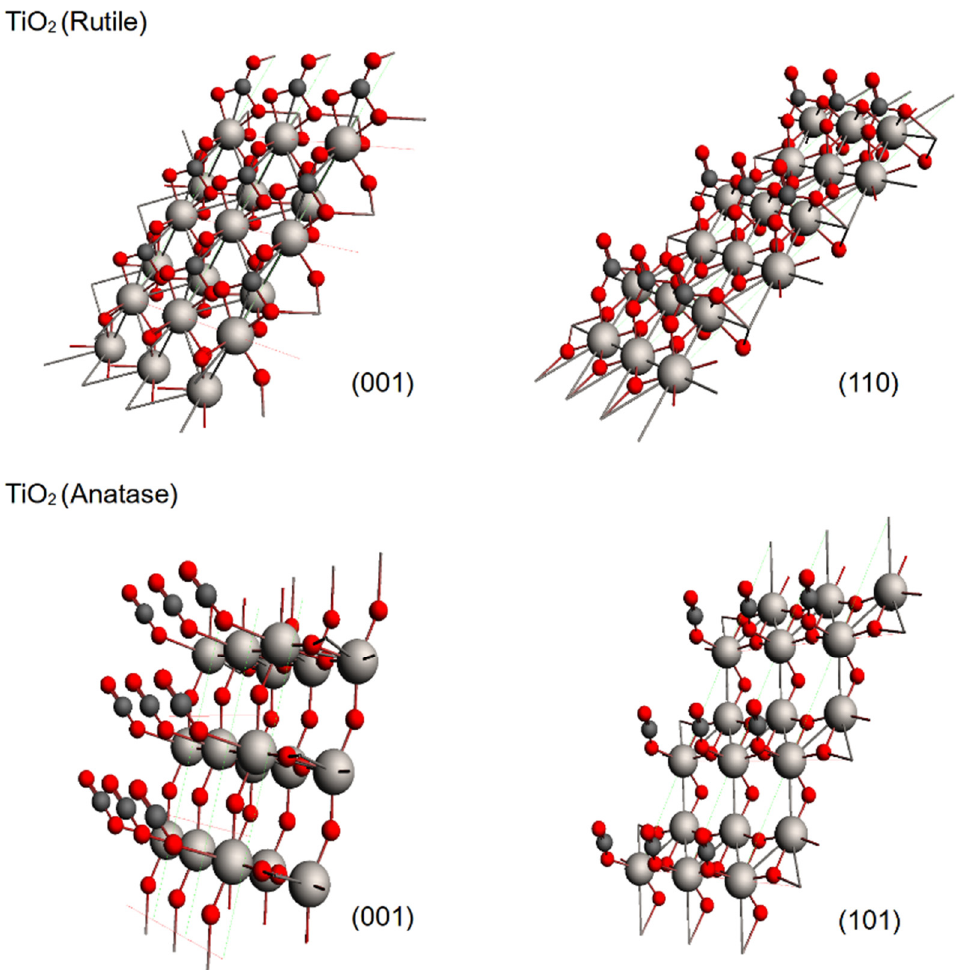
Figure 1. Optimized geometries for the adsorption models over the crystalline phases of TiO 2 : top: (001) and (110) rutile planes; bottom : (001) and (101) anatase planes. Atomic representations: titanium atoms as white spheres, oxygen atoms as red spheres and carbon atoms as dark gray spheres.